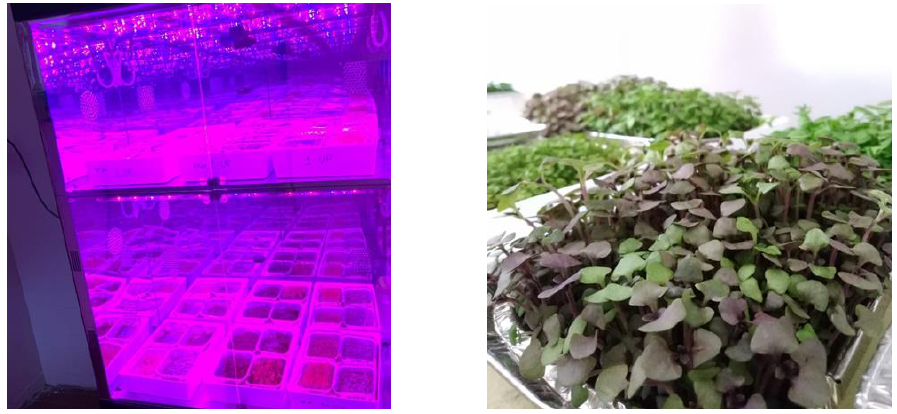
Figure 1. From left to right: Micro Experimental Growing (MEG ® ) chamber and harvesting stage of indoor-grown microgreens.